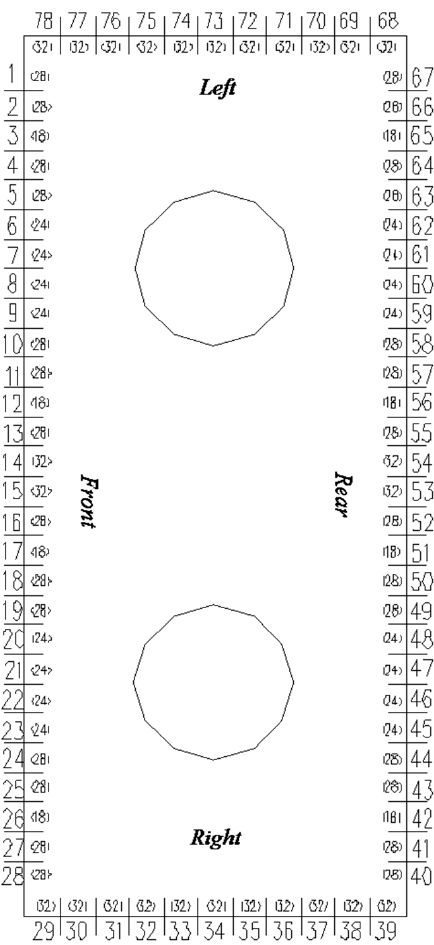
Figure 7. Schematic of Vertical Circuit Division of Lower Furnace.